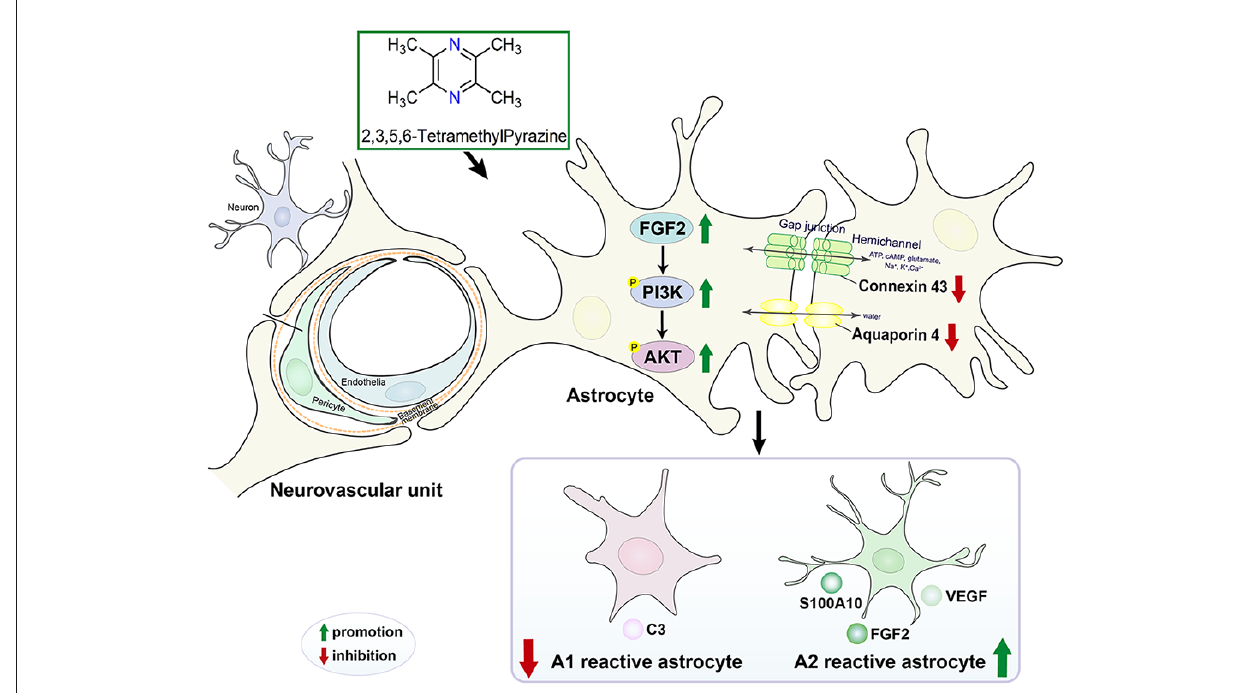
FIGURE9 The mechanism diagram that TMP maintained NVU and reduced the neurological injury caused by cerebral